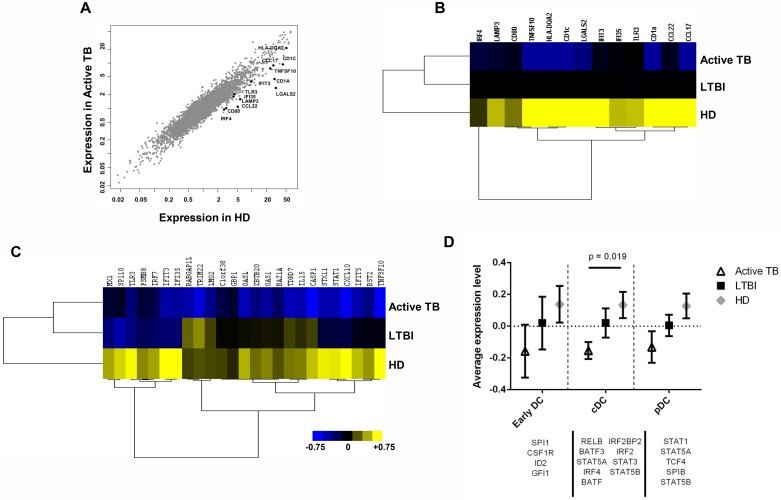
Downregulation of IFN-target genes in IFN-DCs derived from active TB patients.A, Scatter plot of gene expression levels between active TB and HD groups showing downregulation of selected genes in active TB compared to HD. B, Heat map of selected genes downregulated in active TB compared to HD; median centered Log2 values are shown. Expression values of LTBI are also included. C, Hierarchical clustering of 25 genes belonging to IFN signal differentially expressed among active TB, LTBI and HD, built on mean corrected values. In both B and C, values are expressed on a blue-black-yellow gradient. Yellow, increased expression; blue, decreased expression. D, Mean centered expression levels of genes coding transcriptional factors regulating DC development. Statistical significance was analyzed by Student’s t-test (n = 5/group).